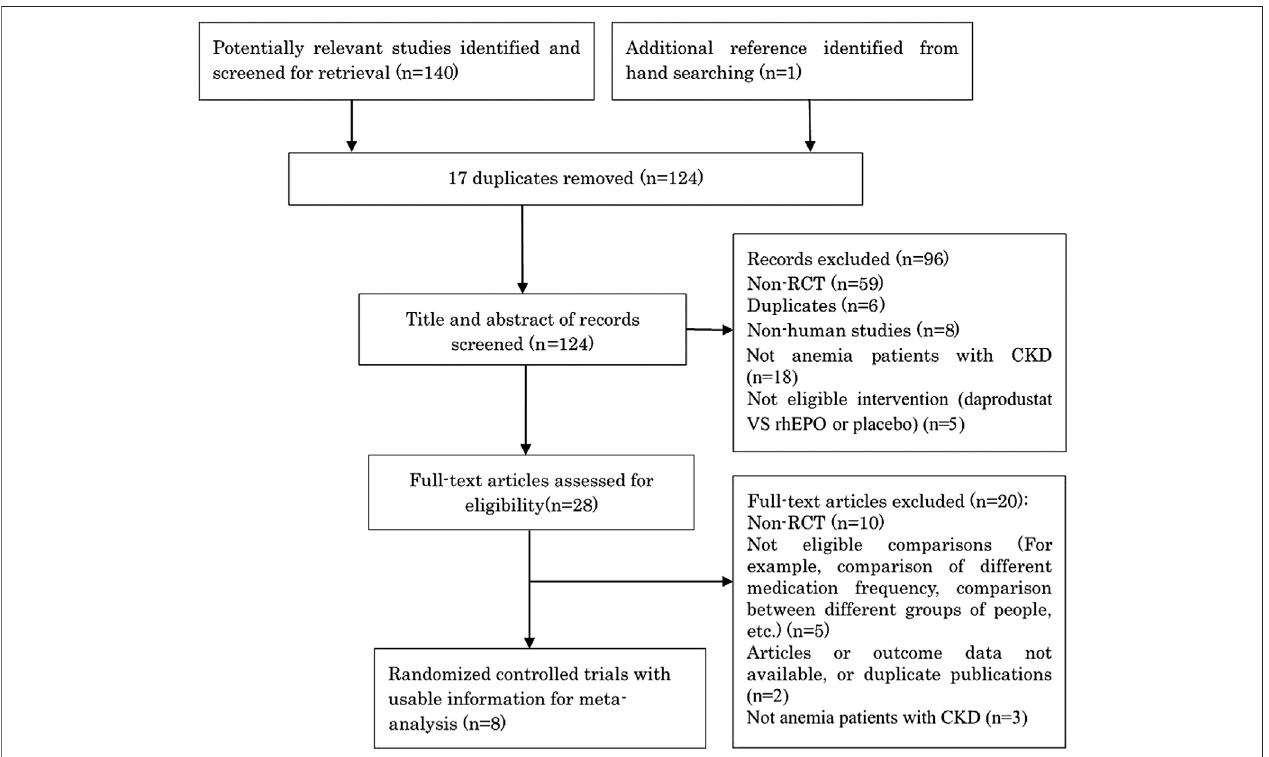
FIGURE 1 | Flow chart of literature search and